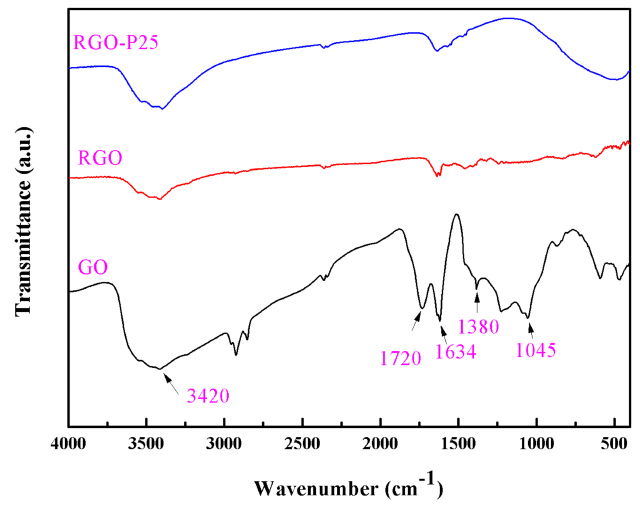
Figure 6. The FT-IR spectra of GO, RGO and RGO-P25 samples.